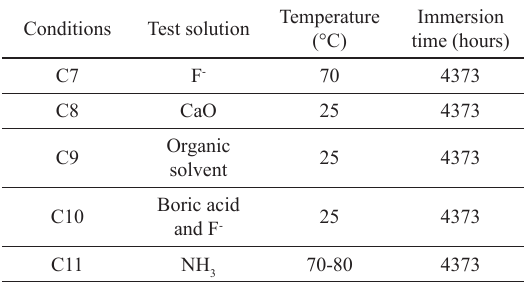
Table 3. In situ test